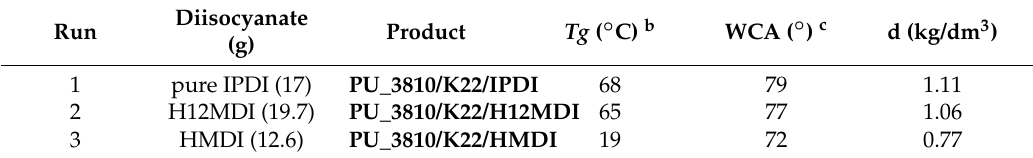
Table 2. Diisocyanate Effect in Polyurethane preparation with Alcupol R3810/Borchi ® Kat 22 a